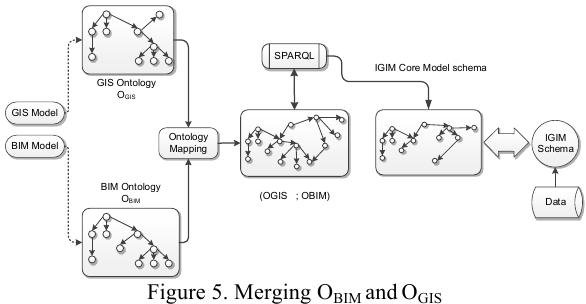
Figure 5. Merging O BIM and O